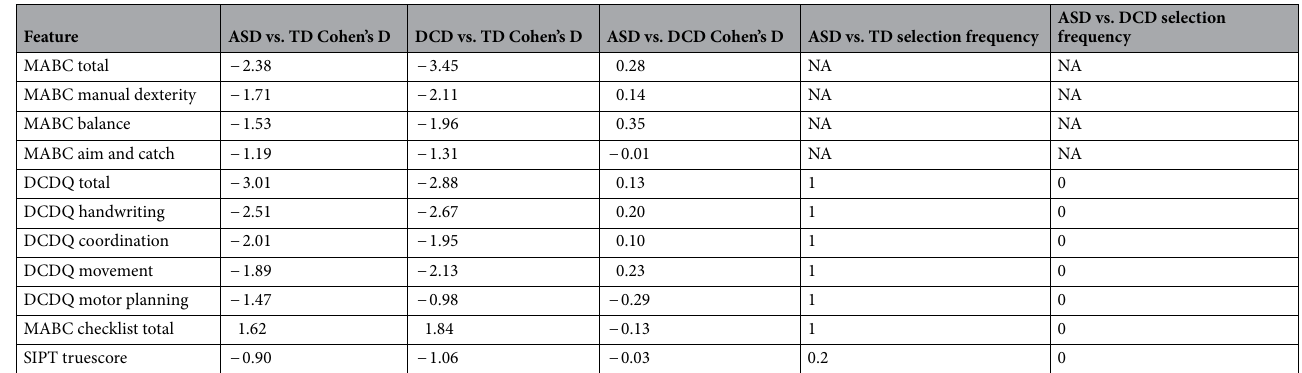
Table 1. Importance of motor features in distinguishing ASD. The first three columns report Cohen’s d effect size from paired comparisons between subject groups. The last two columns report selection frequency of each feature by univariate feature selection for the full RDoC + M + S feature set across all 2000 cross validation loops for each of our two decoders (ASD vs. TD and ASD vs. DCD). Motor features (rows) sorted by selection frequency.